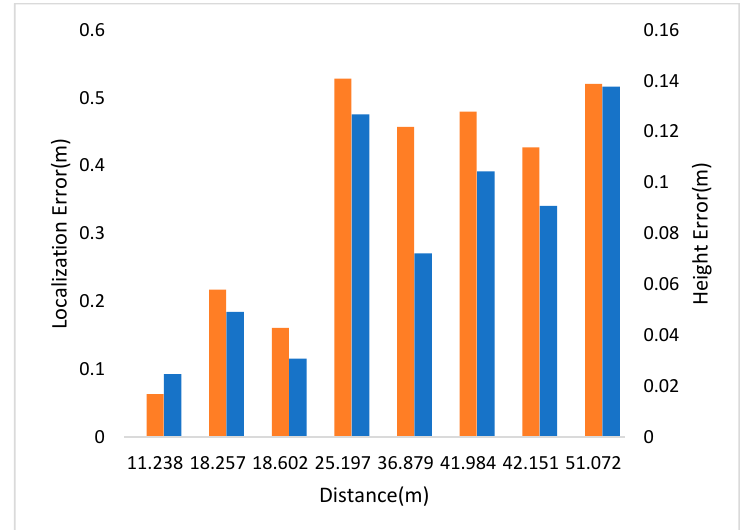
Figure 6. Localization and height error of Scene 2 in CUMTB-Campus.